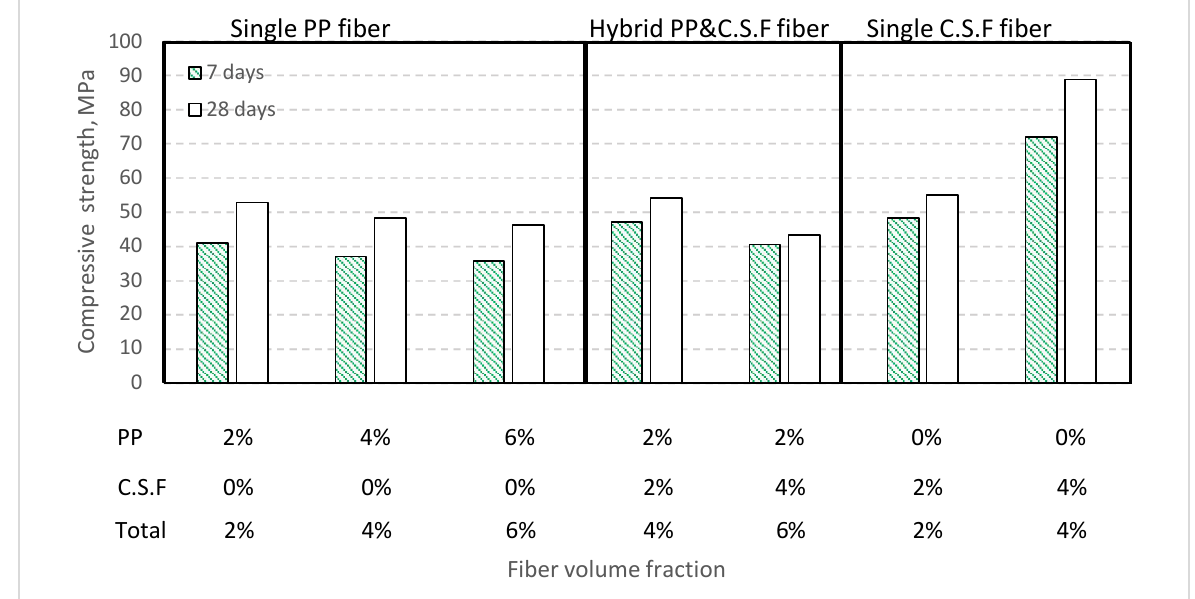
Figure 13. Effect of lightweight fiber hybridization on 7 and 28-day concrete compressive strength.